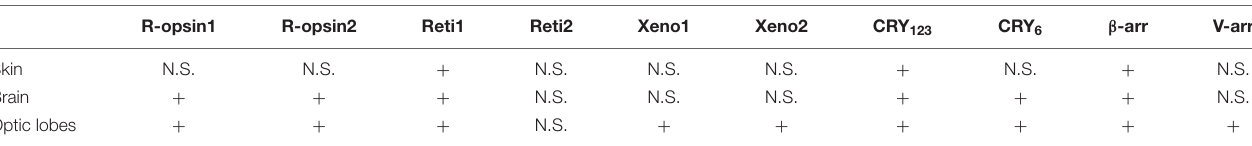
TABLE 3 | Expression of light sensitive molecules in